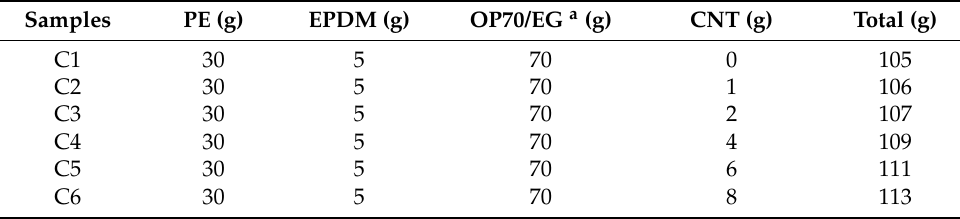
Table 1. Mass (g) of the as-prepared thermal conductivity enhanced phase change composite material samples.